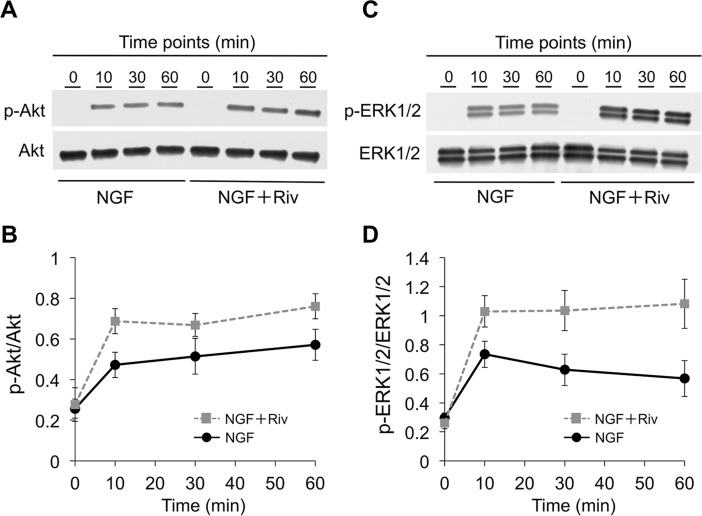
Influence of Riv on NGF-induced phosphorylation of Akt and ERK1/2 in PC12 cells.PC12 cells underwent various durations of treatment (0, 10, 30, or 60 min) with NGF in the presence or absence of Riv (100 μM) (A, C) Total protein lysates were collected and subjected to western blotting for detection of phosphorylation status of Akt and ERK1/2. (B, D) The intensity of the p-Akt polypeptide band was normalized to that of the total Akt band (p-Akt/Akt) (B), while the intensity of the p-ERK1/2 polypeptide band was normalized to that of the total ERK1/2 band (p-ERK1/2/ERK1/2) (D). Results are presented as the mean ± SD of three independent experiments.